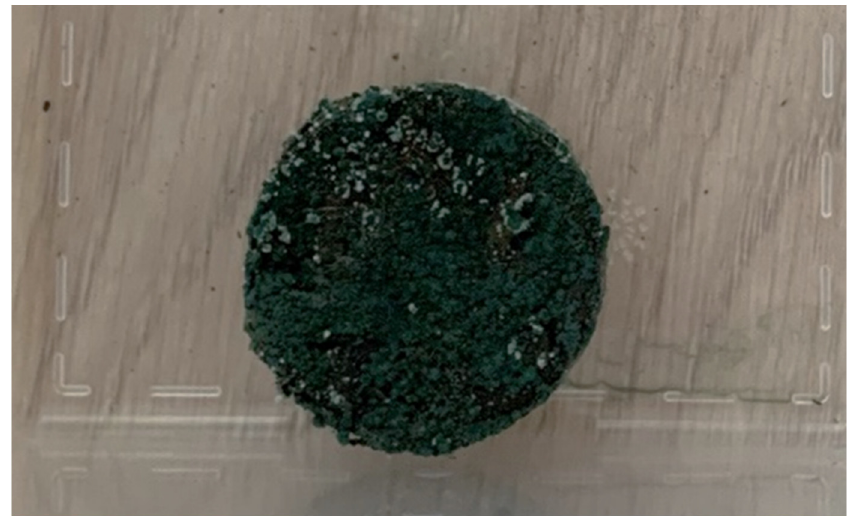
Figure 9. Fungi growth for sample D1 at the end of the incubation period.